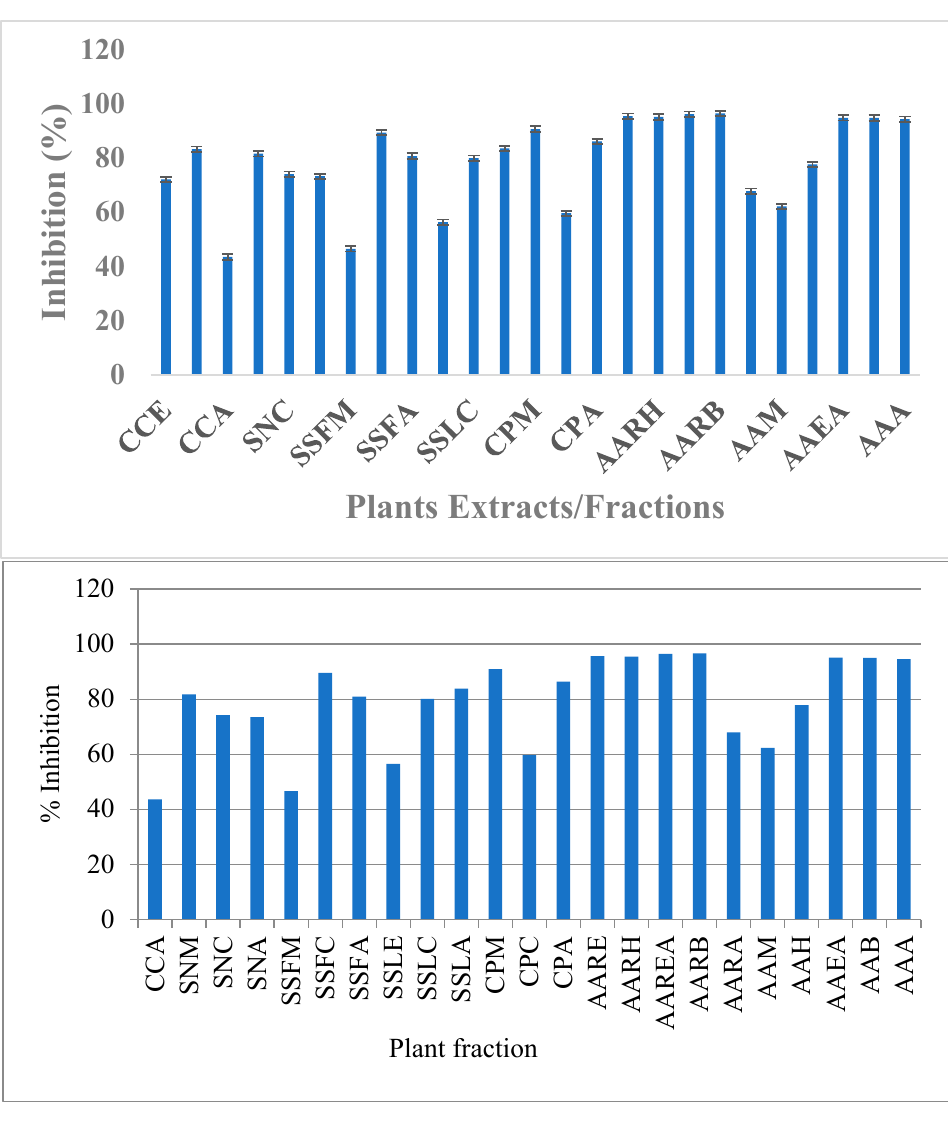
Figure 6. Graph of antidiabetic activity of plant extracts. Table 7. Anti-diabetic activity of plant extracts.